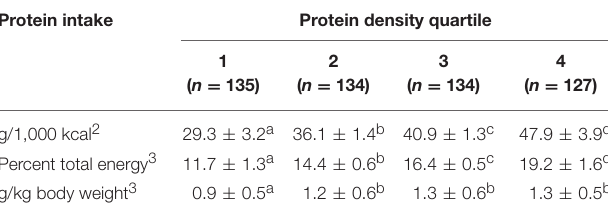
TABLE 1 | Habitual estimated protein intake by protein density quartile in healthy young adults 1 . Protein